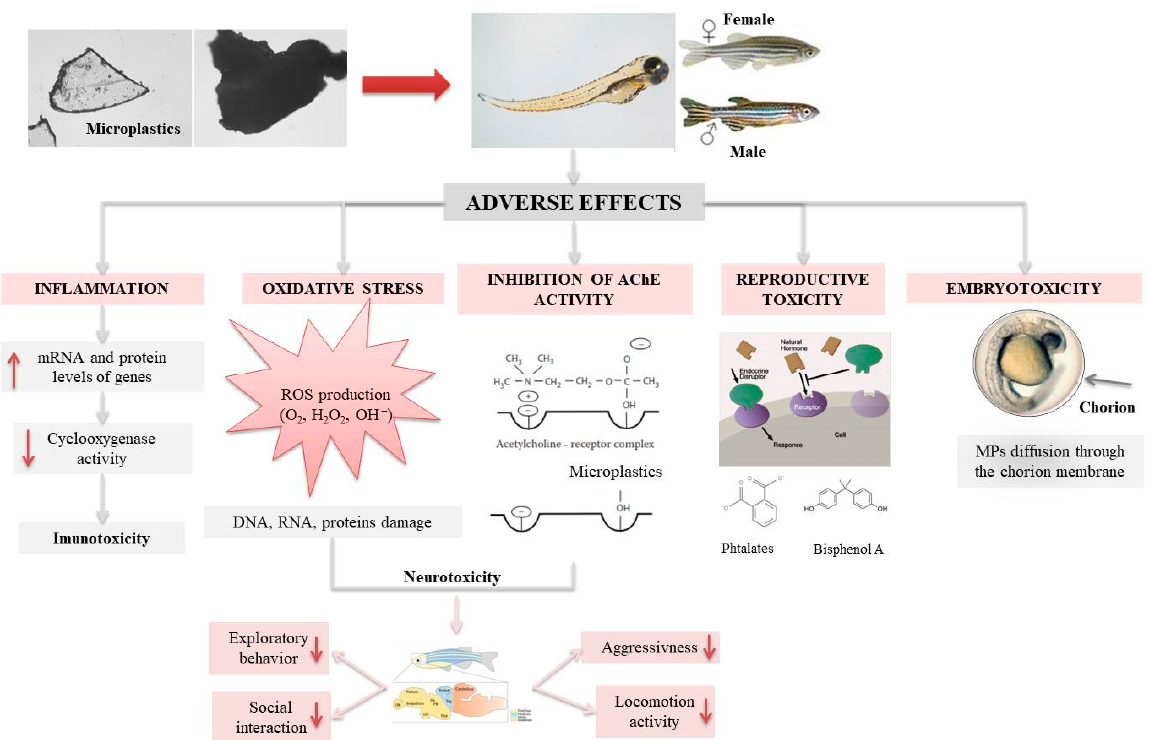
Figure 5. Effects of microplastics on zebrafish.